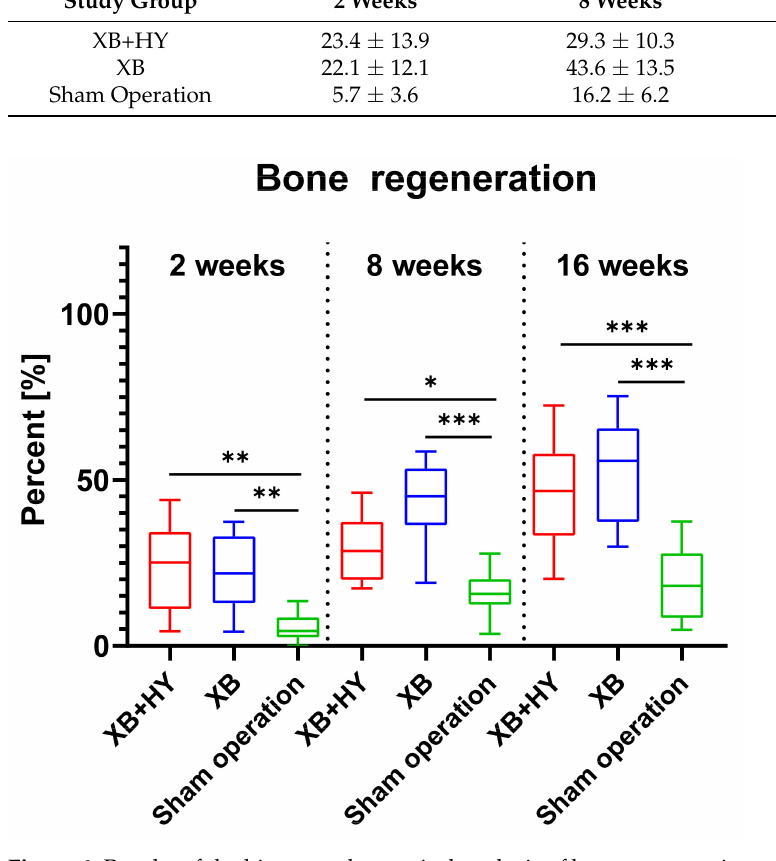
Figure 6. Results of the histomorphometrical analysis of bone regeneration presented as mean and standard deviation (* p < 0.05, ** p < 0.001, *** p < 0.0001, * = inter-individual